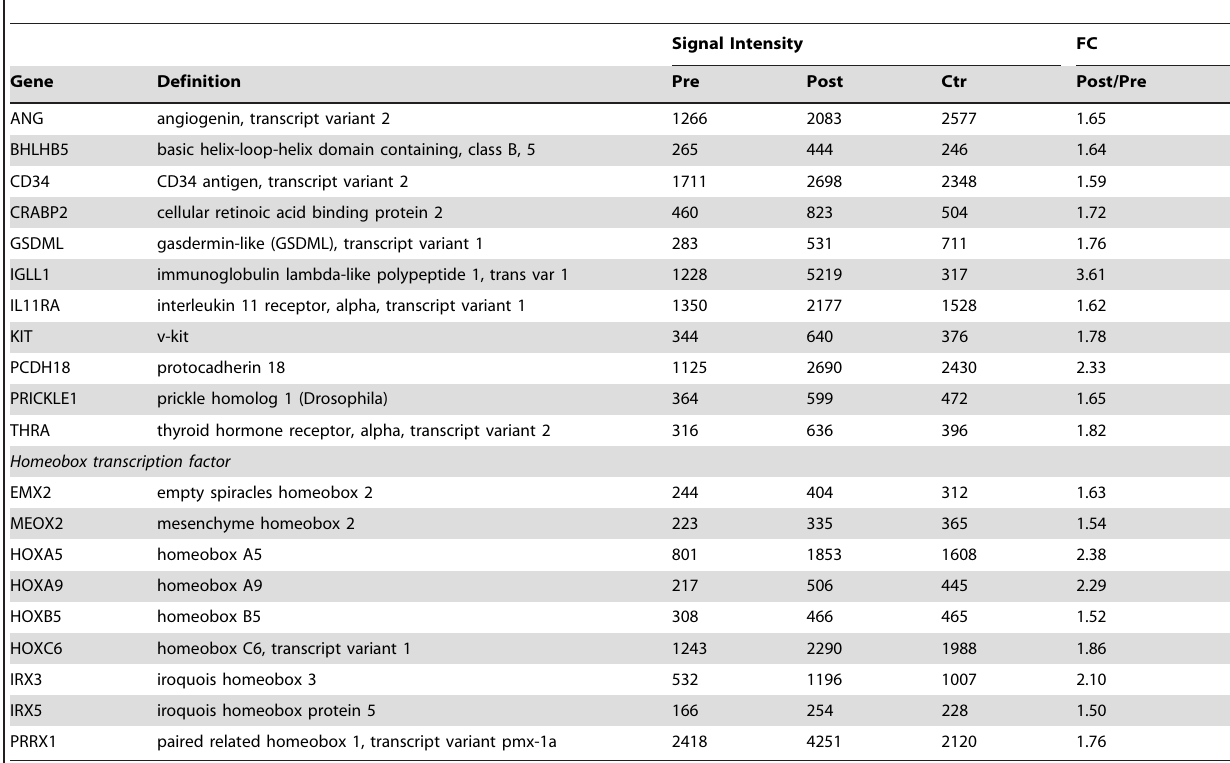
Table 3. Up-regulated genes in adipose tissue after profound fat loss (PANTHER category Developmental processes, q-value= 0).